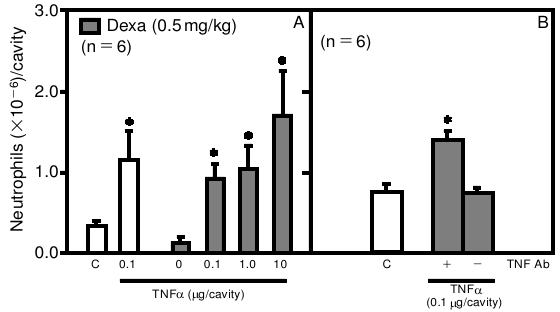
FIG. 3. Effect of dexamethasone pretreatment on the neutrophil migration induced by rmTNF a in mice. ( A ) Bars represent neutrophil migration induced i.p. injection of saline solution (SAL) or of the indicated amounts (in m g/ animal) of rmTNF a into peritoneal cavities of dexametha- sone-pretreated or naive mice (hatched and open bars, respectively). ( B ) Bars represent neutrophil migration in- duced by 0.1 m g rmTNF a , preincubated ( ) or not ( ) with 100 m g of IgG anti-TNF a , into peritoneal cavities of dexa- methasone-pretreated mice. The control animals (SAL) received i.p. injections of saline solution containing IgG anti-TNF a (100 m g/0.2 ml/animal). In both panels, the results are reported as means SEM for six animals in the group. P , 0 05 (Student’s t-test).